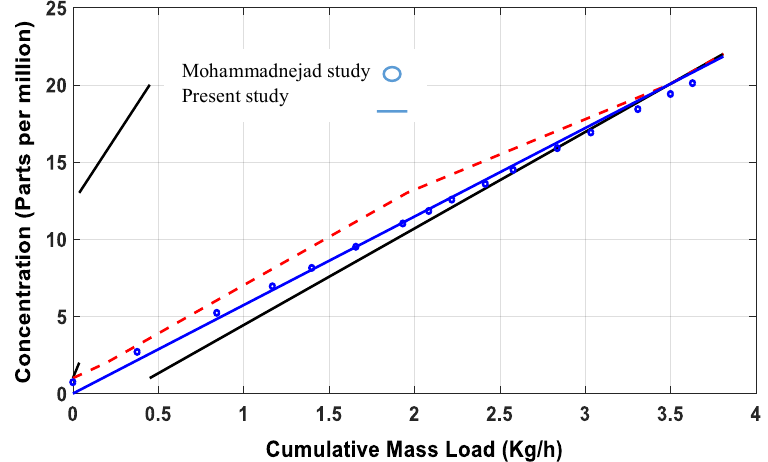
Figure 7 . Resulted curve from the analyzed algorithm